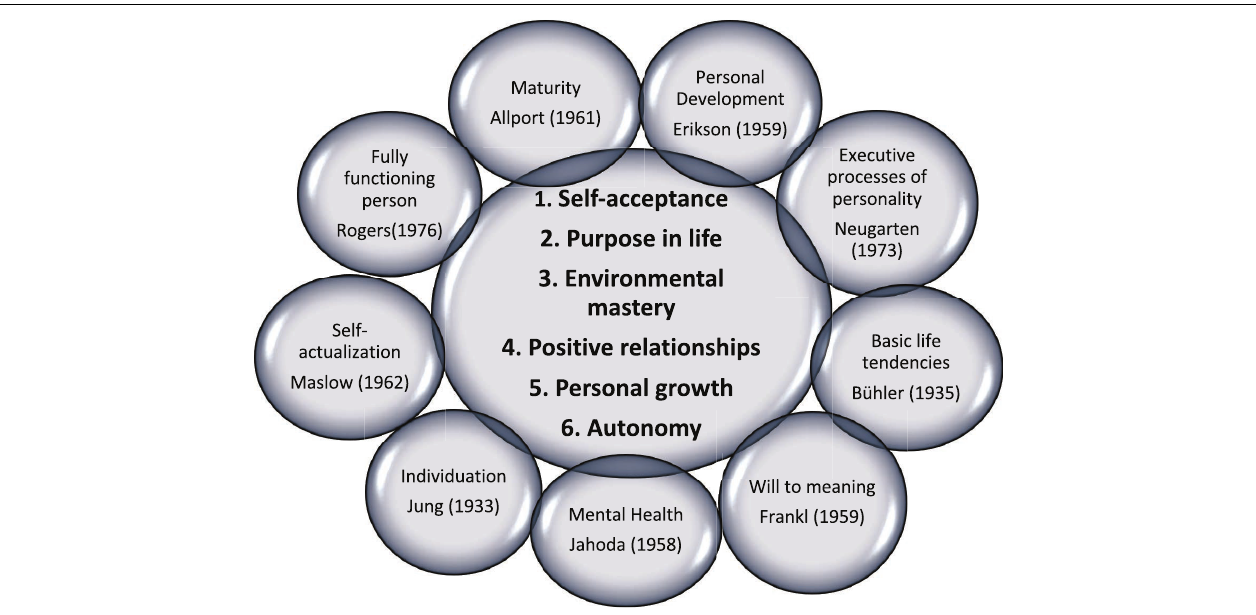
FIGURE 1 | Six core dimensions of eudaimonic well-being and their conceptual foundations. Adapted from Ryff and Singer (2008, p. 20). Copyright by Springer 2016. Used with